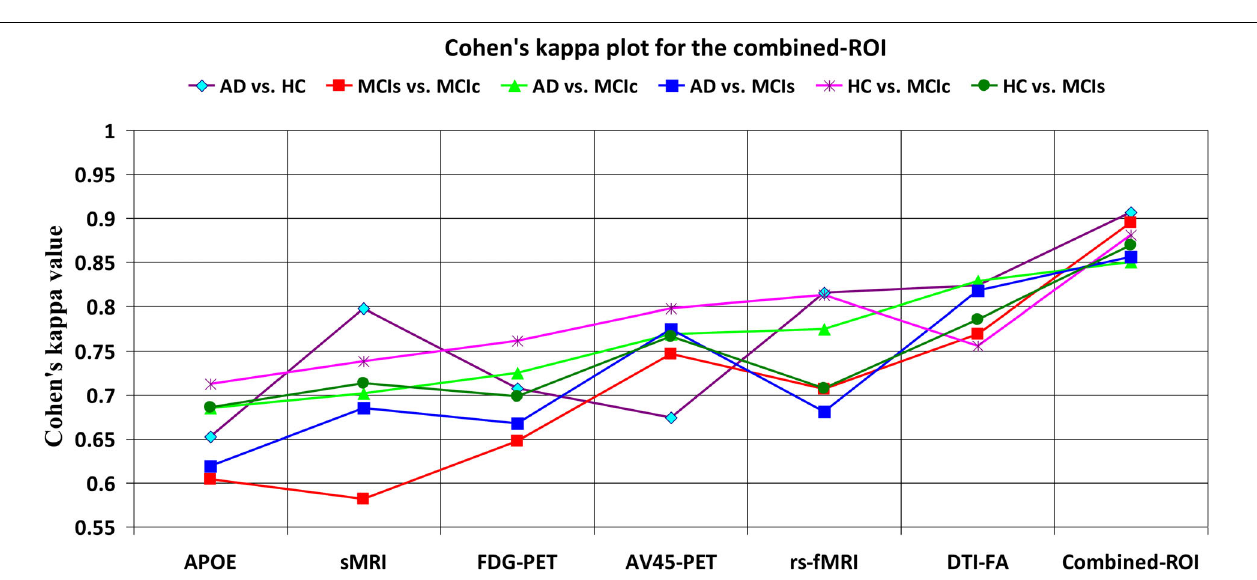
FIGURE 5 | Cohen’s kappa plot for AD vs. HC, MCIs vs. MCIc, AD vs. MCIs, AD vs. MCIc, HC vs. MCIs, and HC vs. MCIc are grouped using whole-brain parcellation analysis. The above graph clearly shows the benefit of the combined-ROI modality over any single modality.